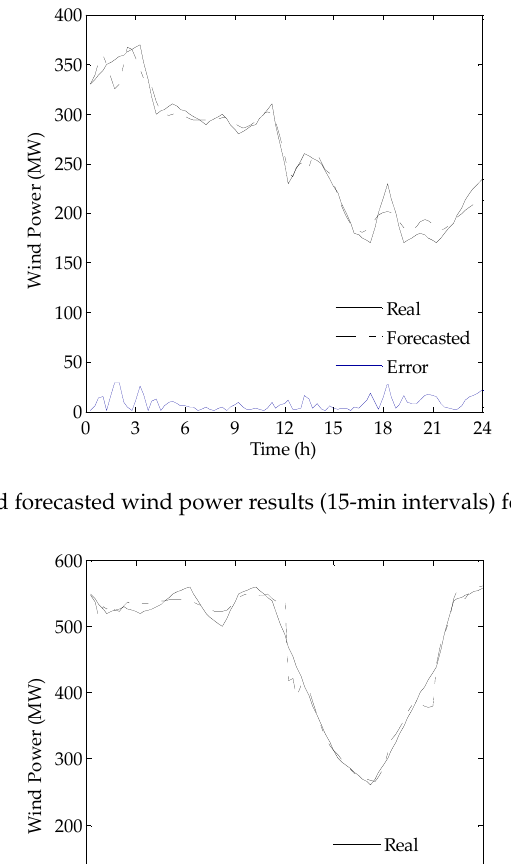
Figure 13. Real and forecasted wind power results (15 ‐ min intervals) for the Spring day.